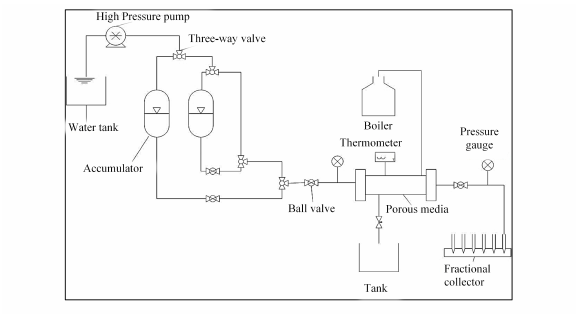
Fig. 1. The flooding test set up for apparent viscosity in porous